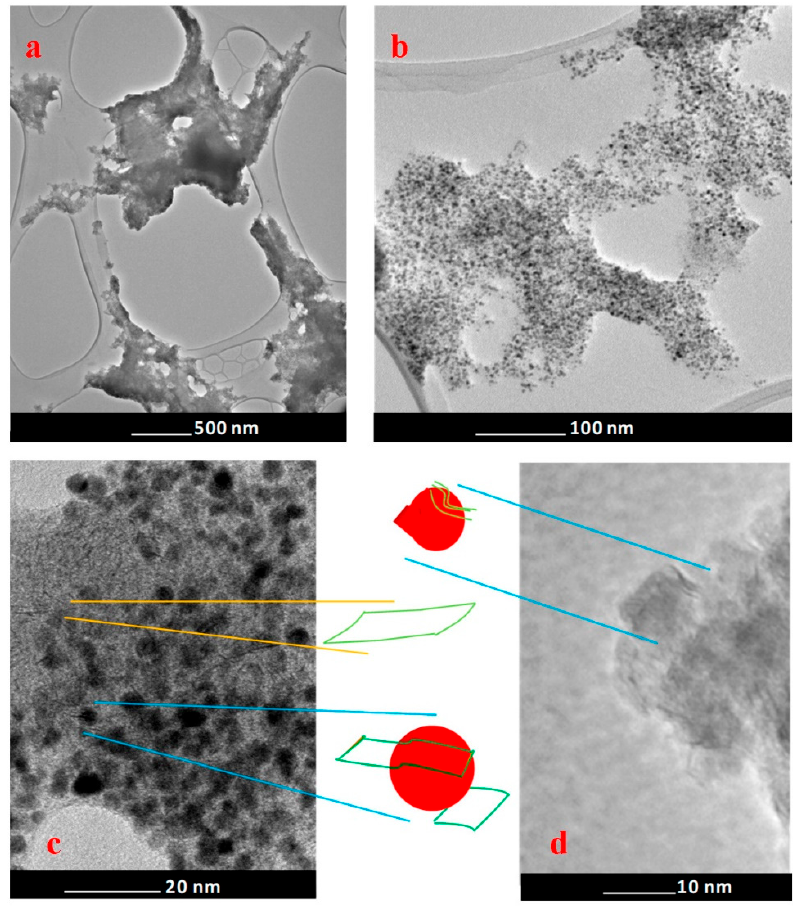
/ MoS ff erent 2 nanocatalyst at di